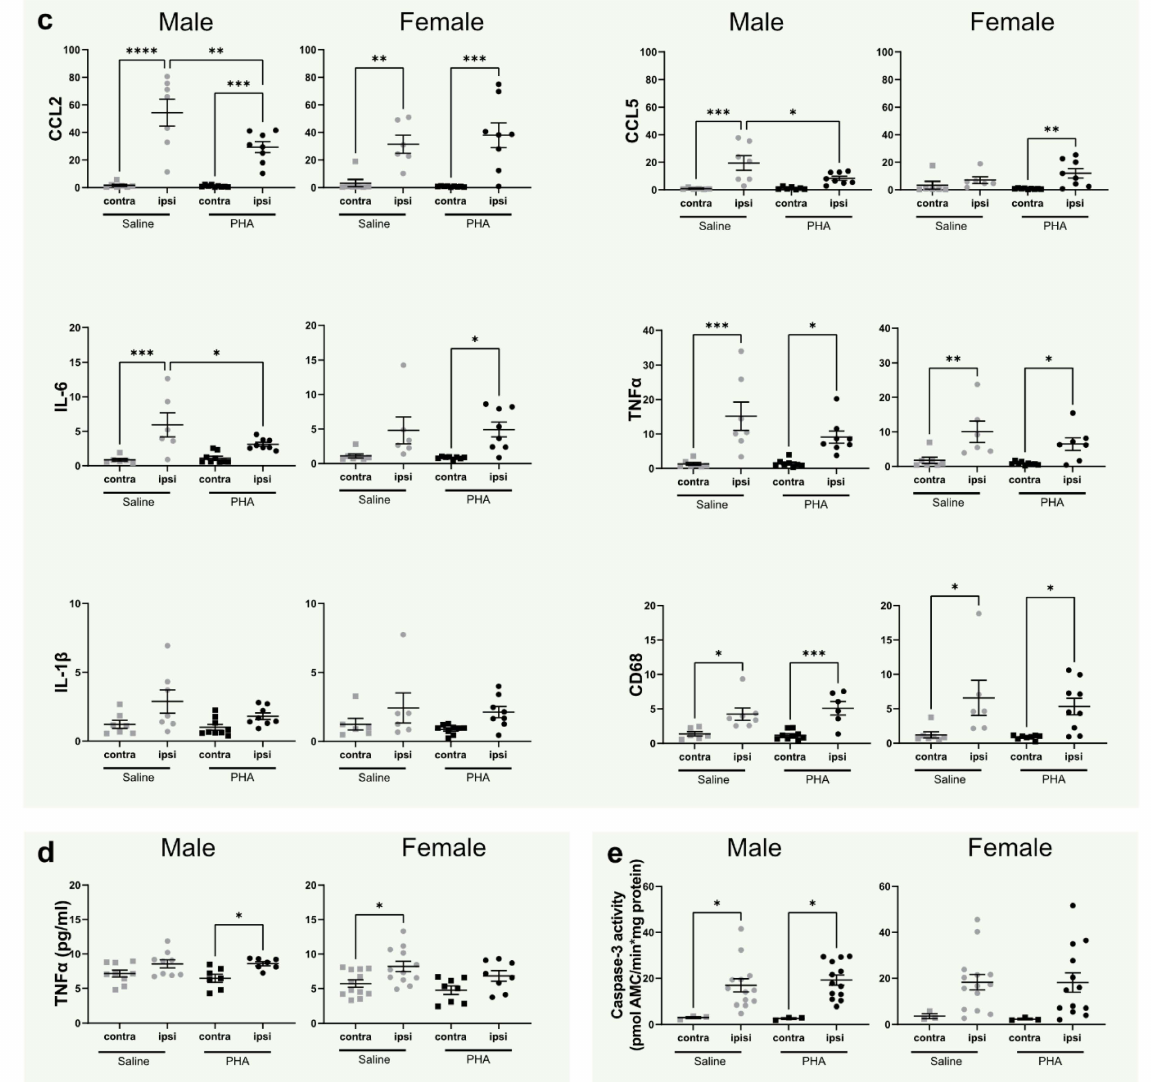
Figure 1. α 7nAChR activation decreases CCL2/MCP-1, CCL5/RANTES and IL-6 gene expression in the brain in male mice 24 h after neonatal hypoxia-ischemia. ( a ) Experimental timeline. Male ( left ; n = 13–14 per group) and female ( right ; n = 13 per group) C57BL/6 pups were subject to HI on PND9–10 immediately followed by i.p. injections with either α 7nAChR agonist PHA 568487 (8 mg/kg, black) or saline (gray) and then sacrificed 24 h after HI. ( b , c ) mRNA expression of cerebral Chrna7 ( b ) and CCL2/MCP-1, CCL5/RANTES, IL-6, TNF α , IL-1 β and CD68 ( c ) in the injured (ipsi) and non-injured (contra) hemisphere 24 h after HI, analyzed with qPCR. Data are expressed as 2 − ∆∆ CT , where the average of the contralateral hemisphere of the saline group was used as the control ( n = 6–8/group). ( d ) Protein levels of TNF α measured with ELISA. ( e ) Caspase-3 activity in the brain 24 h after HI in the injured (ipsi) and non-injured (contra) hemisphere. Data were analyzed with one-way ANOVA followed by Sidak’s multiple comparison test and are expressed as mean ± SEM. p < 0.05 was considered significant. * p < 0.05, ** p < 0.01, *** p < 0.001, **** p <